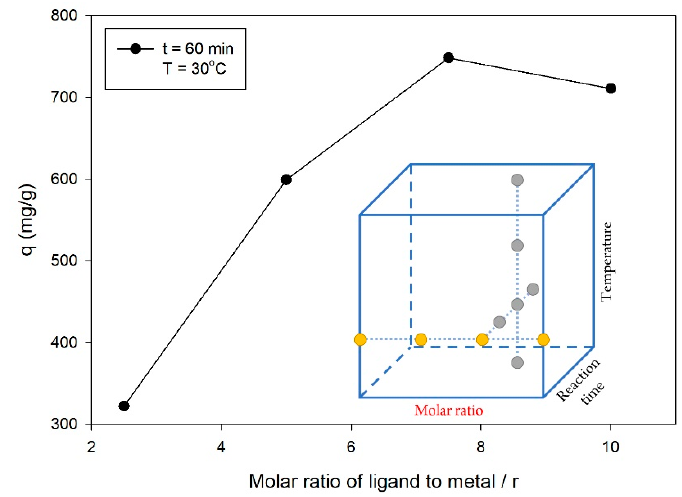
Figure 1. Effect of the molar ratio of ligand to the metal on the 𝑞 value, with the following experi- mental conditions: reaction time = 60 min and temperature = 30 ° C.